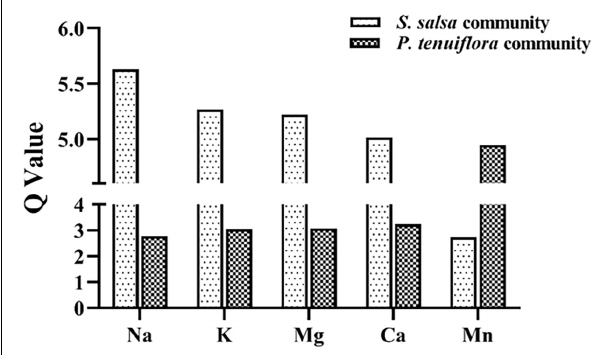
FIGURE 2 | The Q -values of significantly different elements between S. salsa community and P. tenuiflora